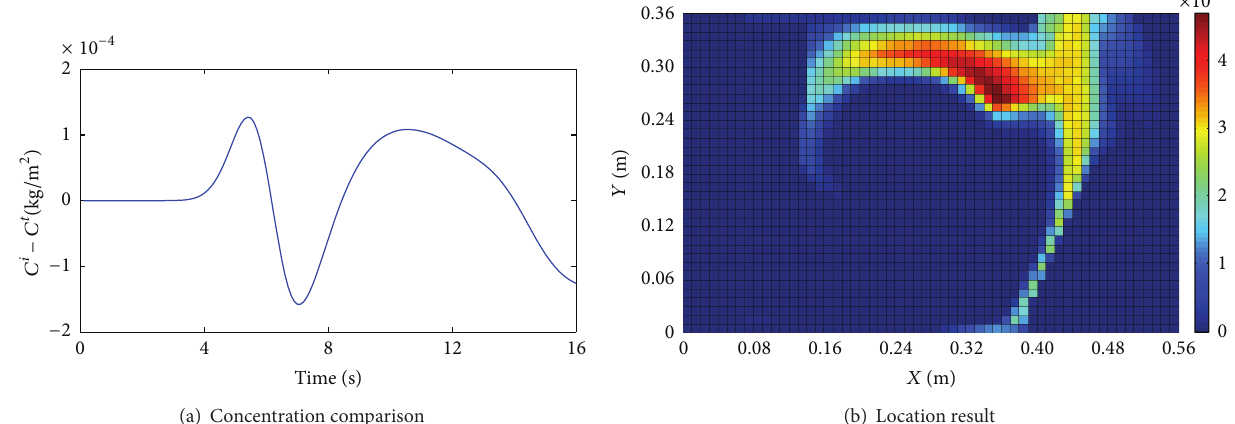
= 0.3 m/s, 𝑆 = 0.5 kg/m 2 ⋅ s, and Φ = 13.12 in